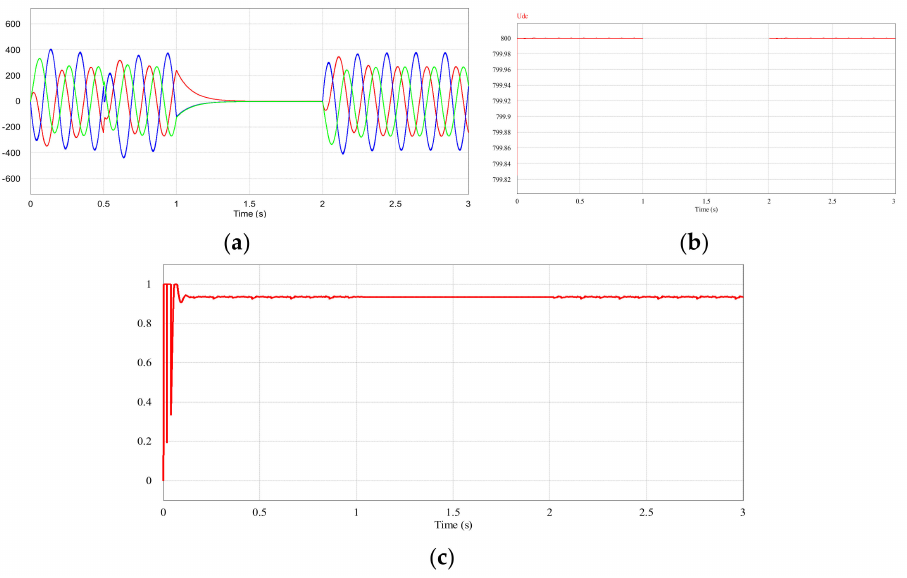
Figure 7. Simulation results under the normal operation of electromagnetic stirring power supply. ( a ) Output currents; ( b ) DC side voltage; ( c ) power